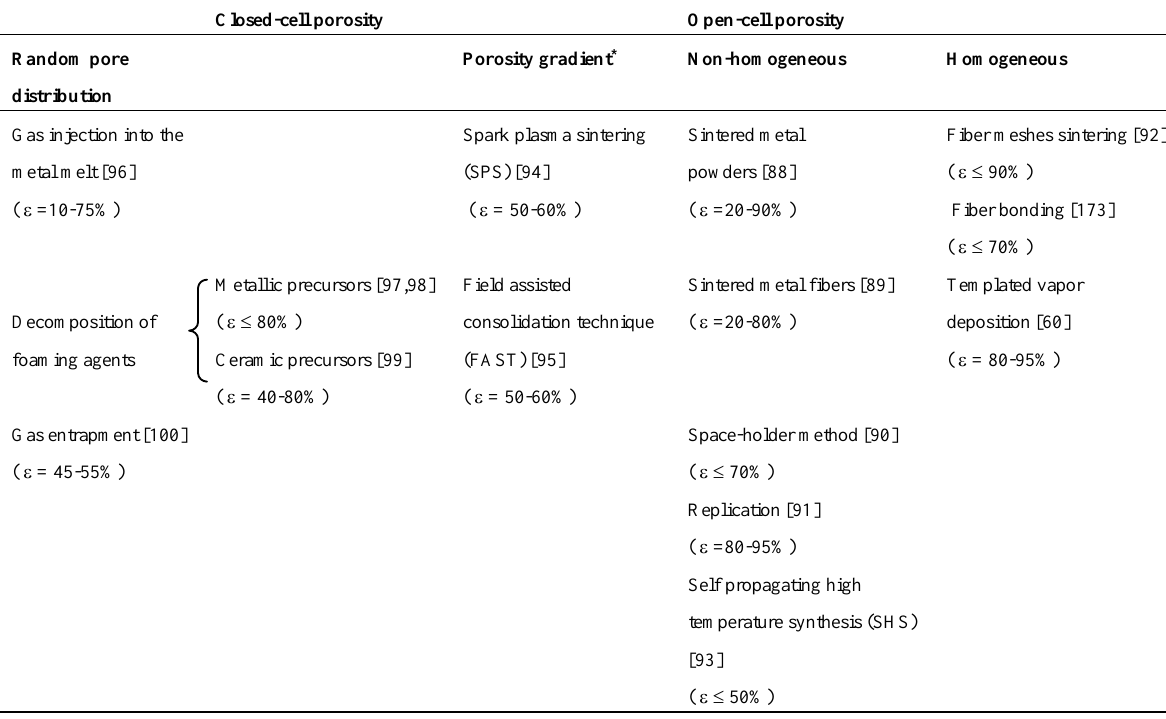
Table 4. Comparison of various conventional fabrication methods for manufacturing metallic porous scaffolds. Numbers in parentheses correspond to the typical porosity (  ) values that each method is able to achieve. Modified from Ryan G. et al.